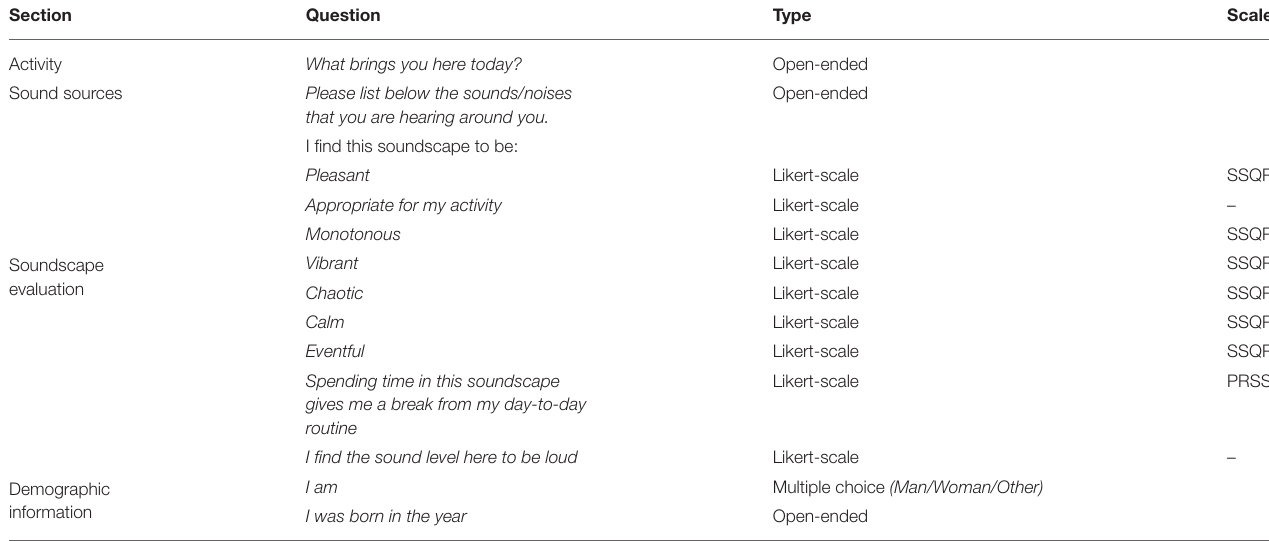
TABLE 2 | Detailed listing of the questions respondents answered that are relevant to the analysis in this paper. Section